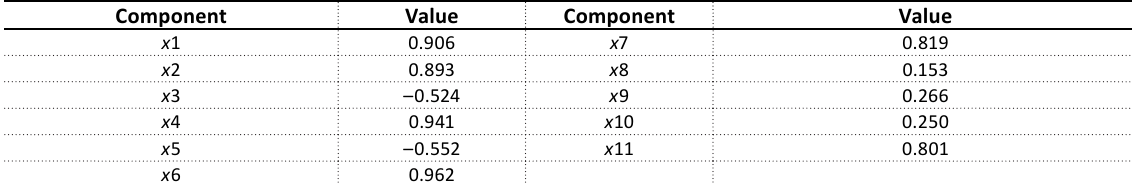
Table 3. Matrix of components (component matrix (a))